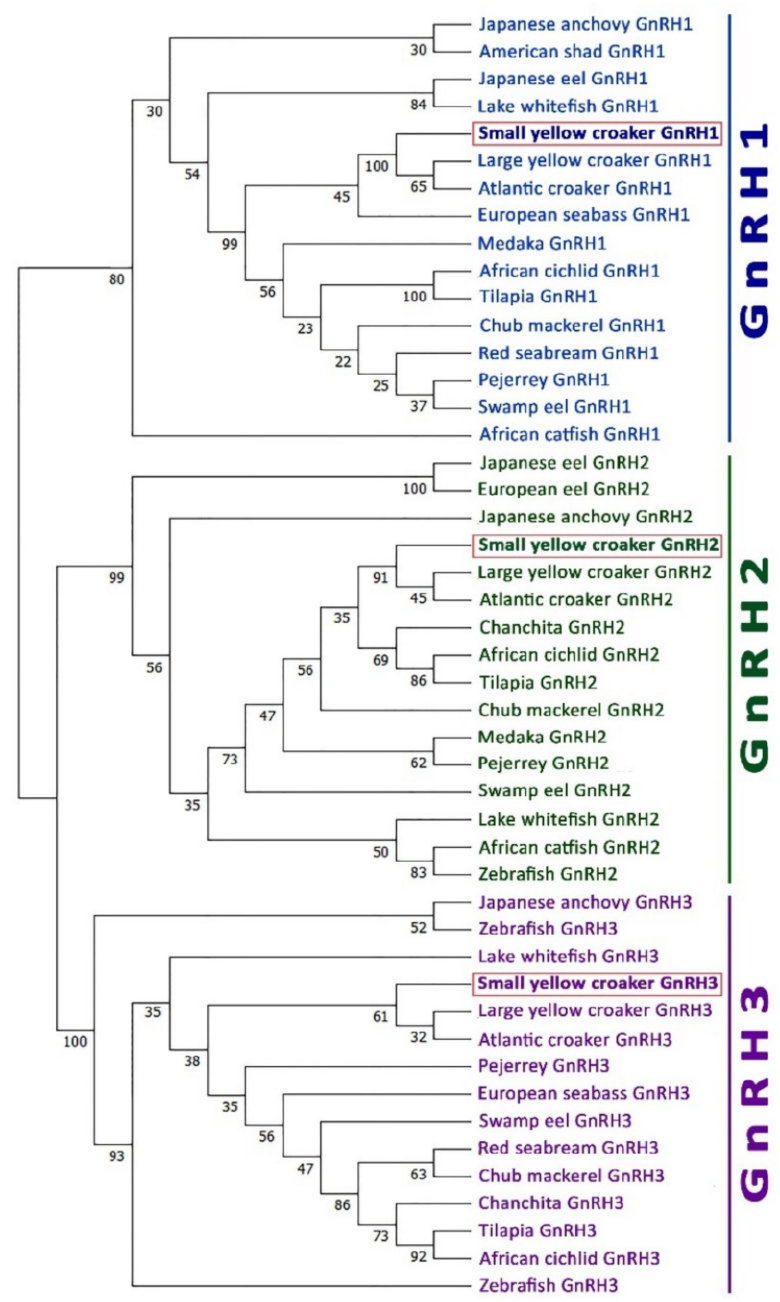
Figure 4. Phylogenetic tree of teleost GnRH isoform sequences. Phylogenetic analysis of 47 teleost GnRH amino acid sequences were performed by the bootstrap neighbor-joining method with 10,000 bootstrap replicates after aligning amino acid sequences of different teleost GnRH isoforms using the MUSCLE alignment option. Numbers at the nodes indicate bootstrap probability. GenBank accession numbers of GnRH sequences used to construct the phylogenetic tree are presented in Supplementary Table